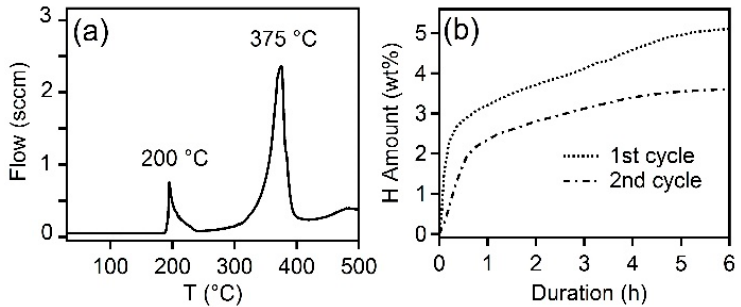
Figure 1. ( a ) Hydrogen desorption profile up to 500 °C; ( b ) isothermal hydrogen release of LiBH 4 -Co 1.34 B at 350 °C in the first two cycles.